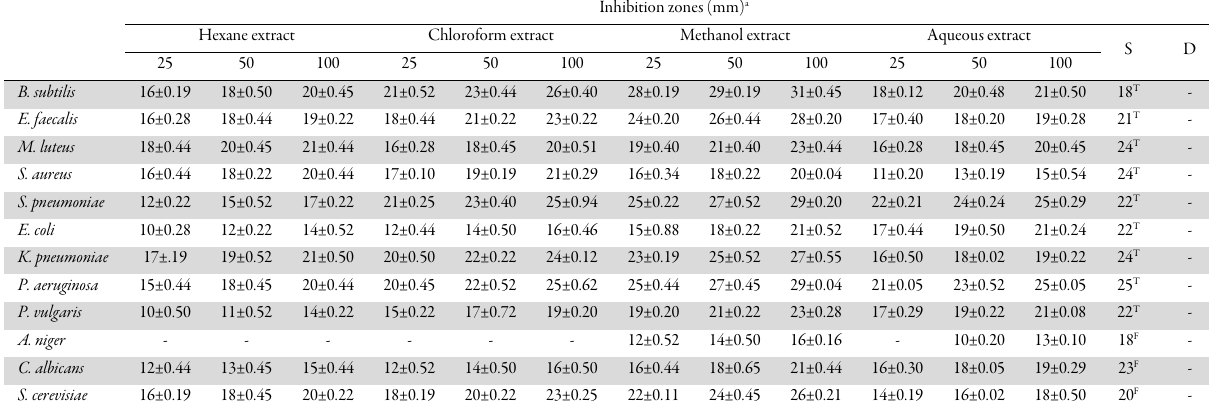
Table 2. The antimicrobial activity of L. glutinosa leaf extracts against the standard